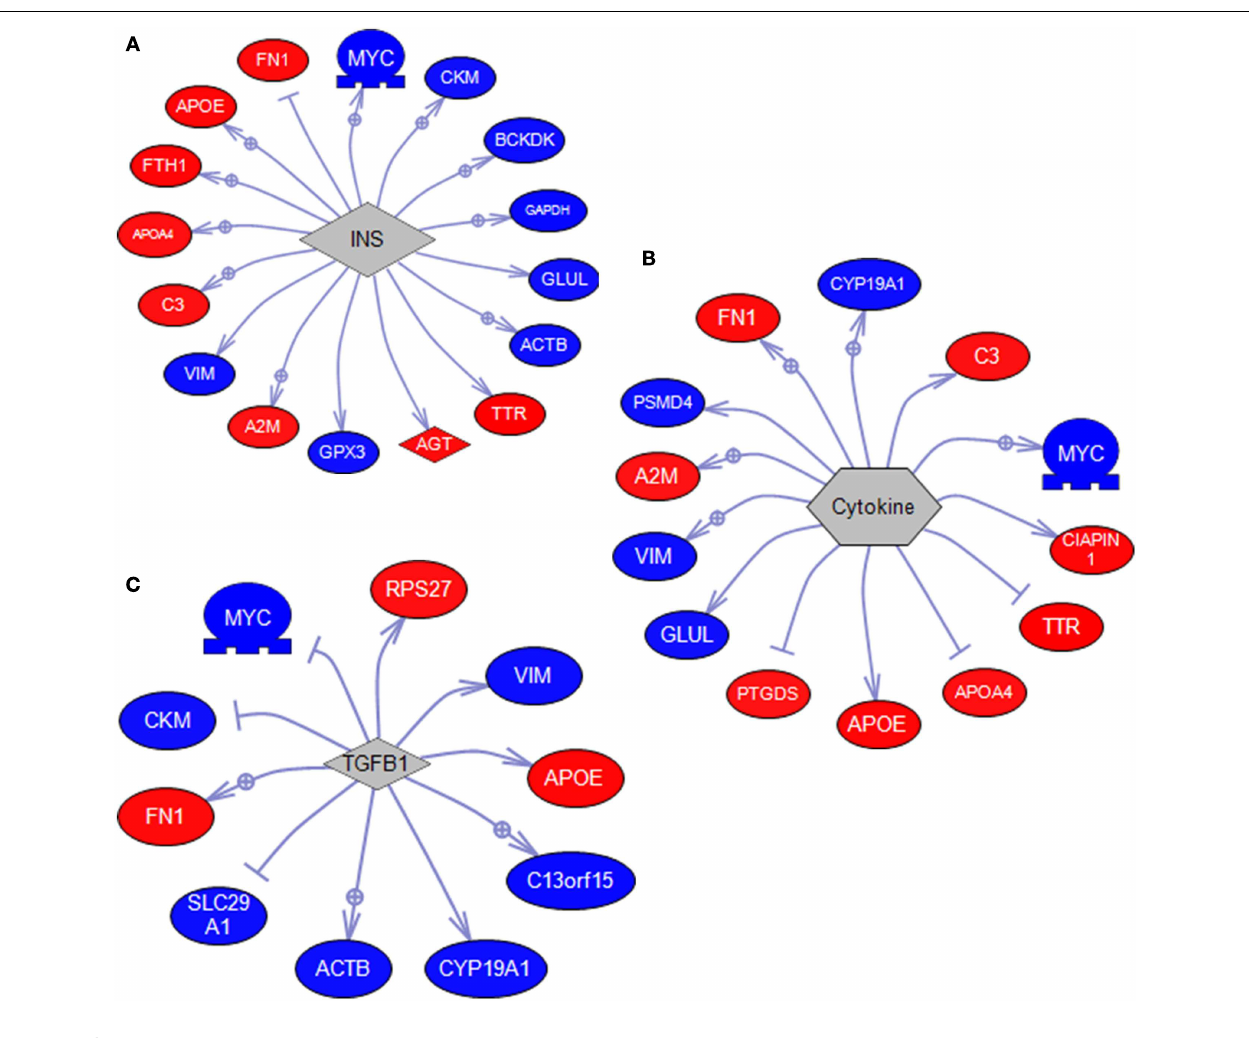
FIGURE 4 | SNEA diagrams showing the gene set target relationships for (A) insulin, (B) cytokines, and (C)TGF β 1, represented by arrows. Arrows with a + in a circle indicate a positive effect in addition to a relationship. Dead-head arrows (–|) indicate a